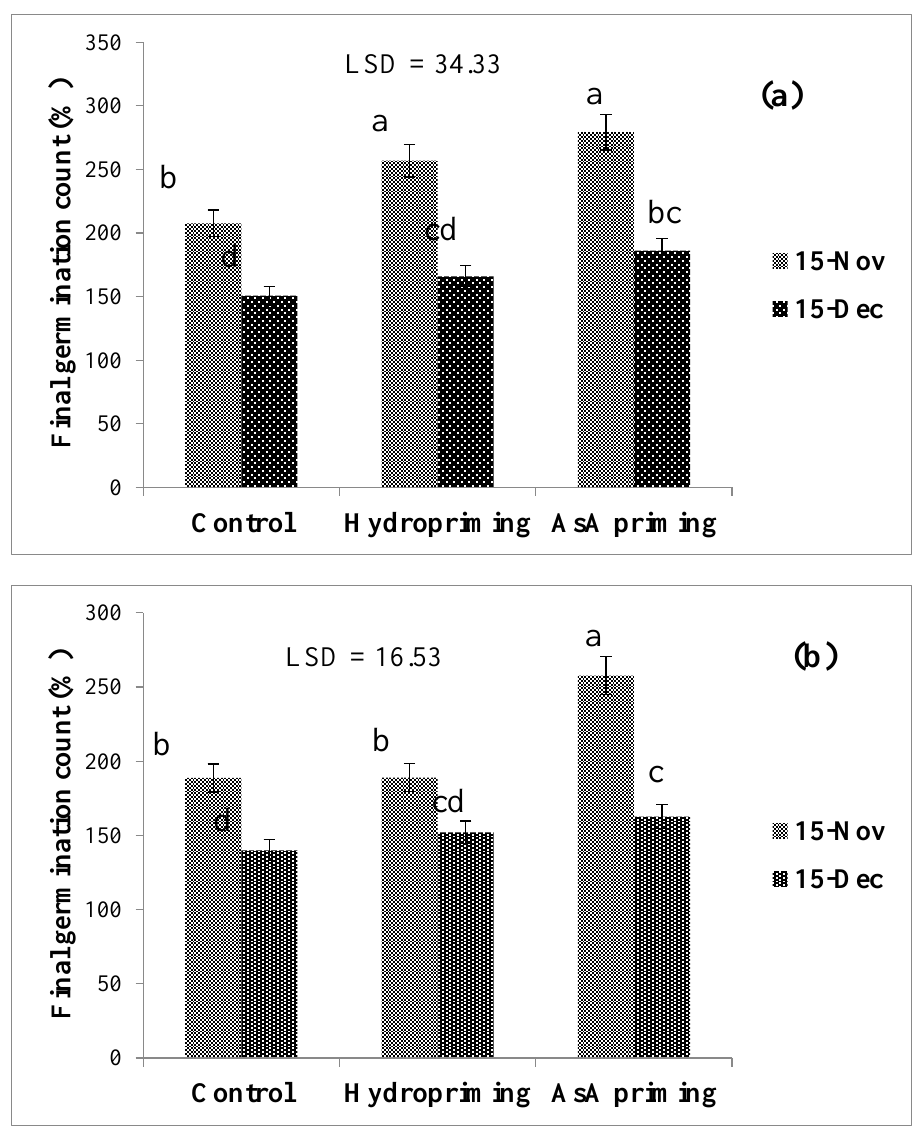
Figure 3. ( a , b ) Interaction between priming techniques and sowing dates for final germination count during 2016-17. Means not sharing same letter (s) differ significantly at p ≤ 0.05.